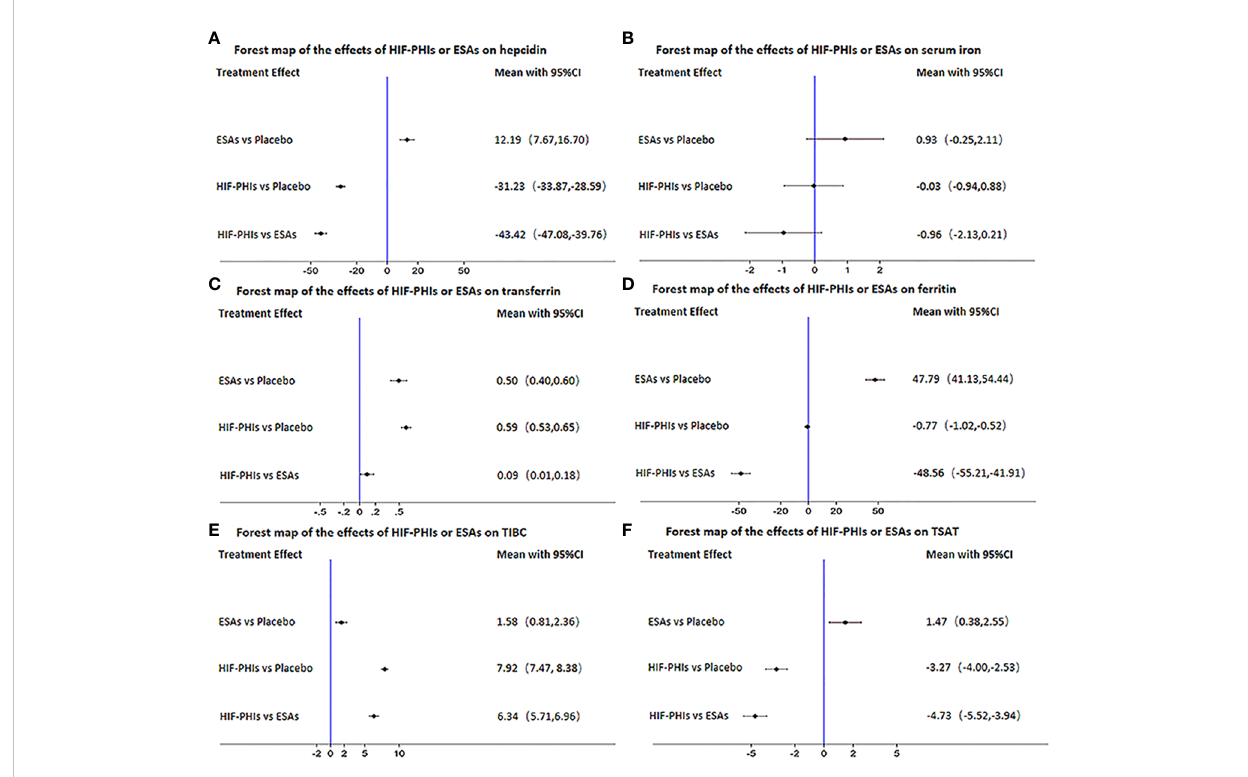
FIGURE 7 Forest map of the effects of three drugs on the regulation of iron metabolism. (A) hepcidin, (B) serum iron, (C) transferrin, (D) ferritin, (E) TIBC, (F)